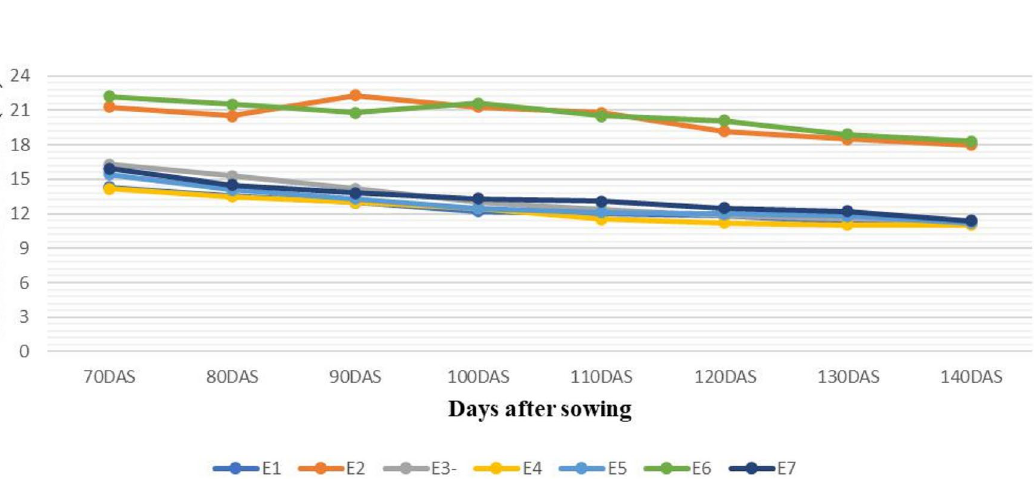
Figure 1. Periodical soil moisture content (%, w/w) under different crop growing